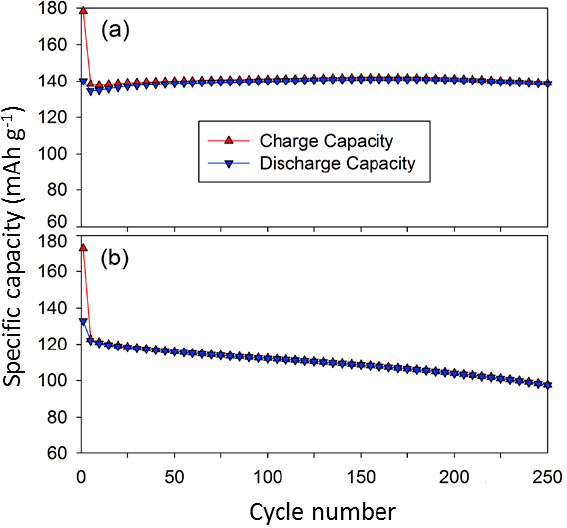
Figure 8. Charge and discharge capacity of Cr, Si-doped LiCo 0.9 Fe 0.1 PO 4 ( a ) half cells and ( b ) full cells as a function of cycle number. Reproduced from [228].